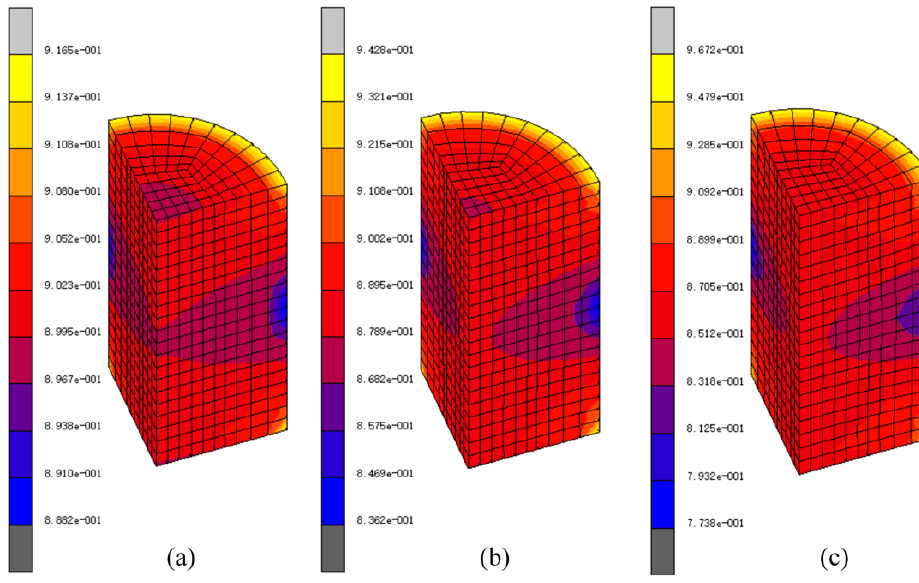
Figure 17. Relative density distributions in compacts at different μ values of ( a ) 0.05, ( b ) 0.2, and ( c ) 0.4.